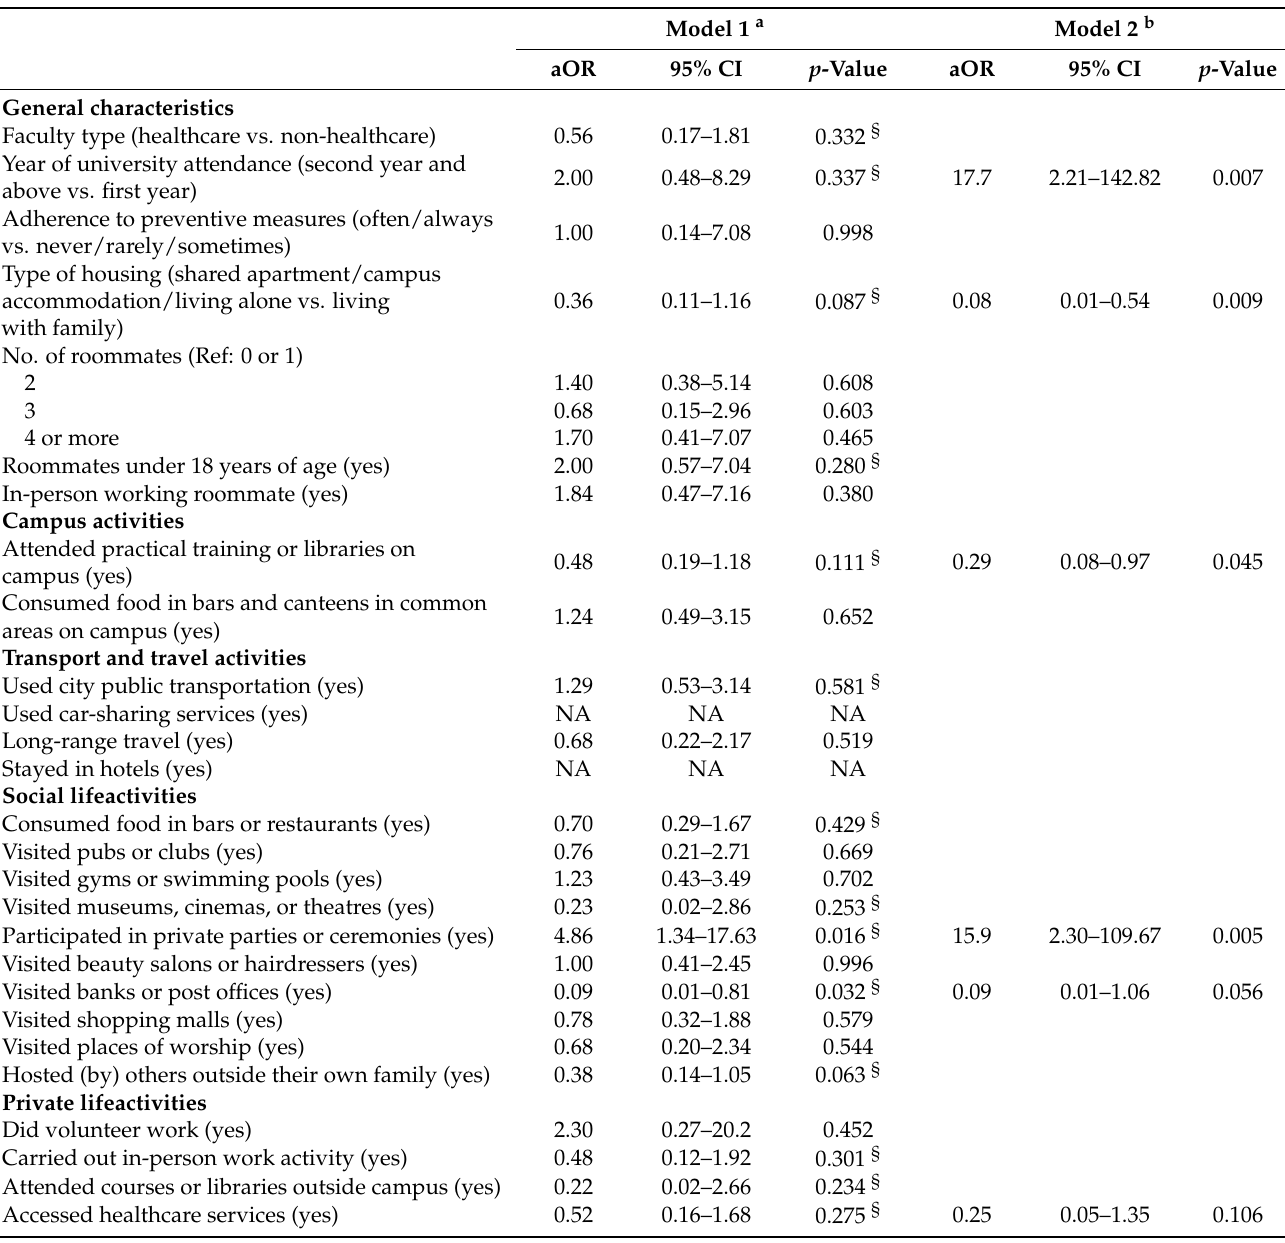
Table 3. Risk of infection with SARS-CoV-2 in cases and matched-control students attending